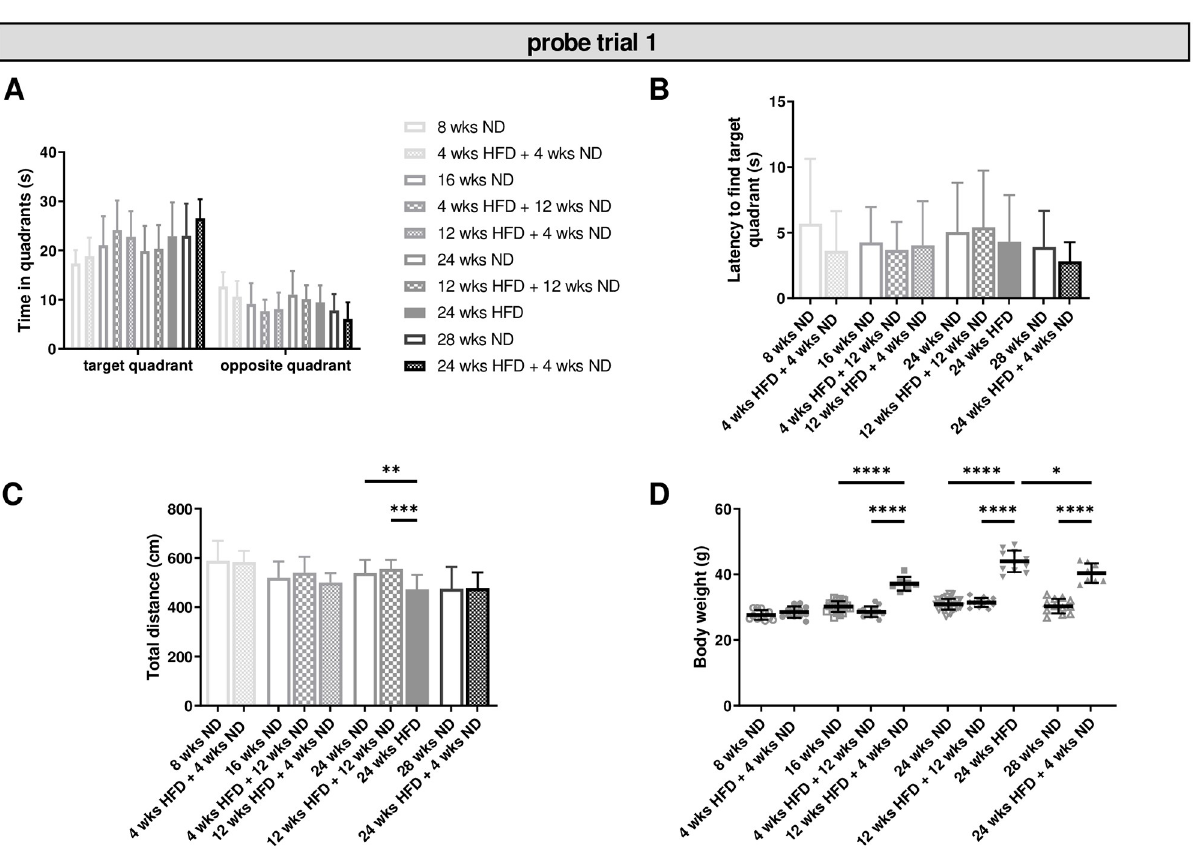
Fig 5. Diet-induced obesity causes no impairment of memory. Memory retention (probe trial one) was tested after four days of training in the MWM test. (A) Diet/dietary change had no effect on the time mice spent in quadrants, while older animals spent more time in the target quadrant. (B) No effect was found regarding the latency to find the target quadrant. (C) Motor activities were reduced in mice receiving 24 wks of HFD compared to age- matched control mice. (D) Diet had a significant effect on body weight and mice benefited from a change to ND after HFD. Data are presented as mean values and error bars indicate SD; 8 wks ND n = 12, 16 wks ND n = 24, 24 wks ND n = 30, 28 wks ND n = 12, 4 wks HFD + 4 wks ND n = 12, 12 wks HFD + 4 wks ND n = 7, 4 wks HFD + 12 wks ND n = 12, 12 wks HFD + 12 wks ND n = 12, 24 wks HFD n = 11, 24 wks HFD + 4 wks ND n = 8; (A): Two-way ANOVA, (B, C, D): One-way ANOVA, Welch-ANOVA, unpaired t test; ���� ; p < 0.0001; ��� p < 0.001; �� p < 0.01; � p < 0.05.